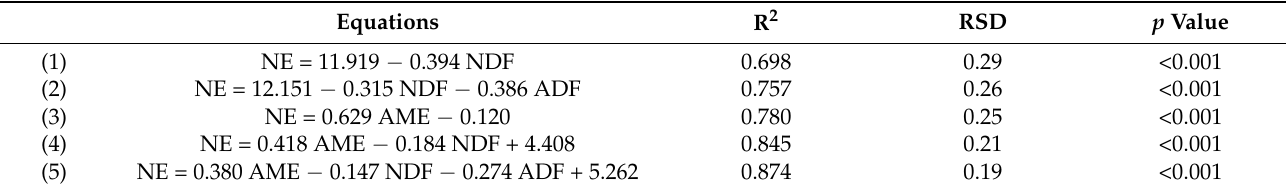
Table 6. Equations of prediction of the NE (MJ/kg) values of